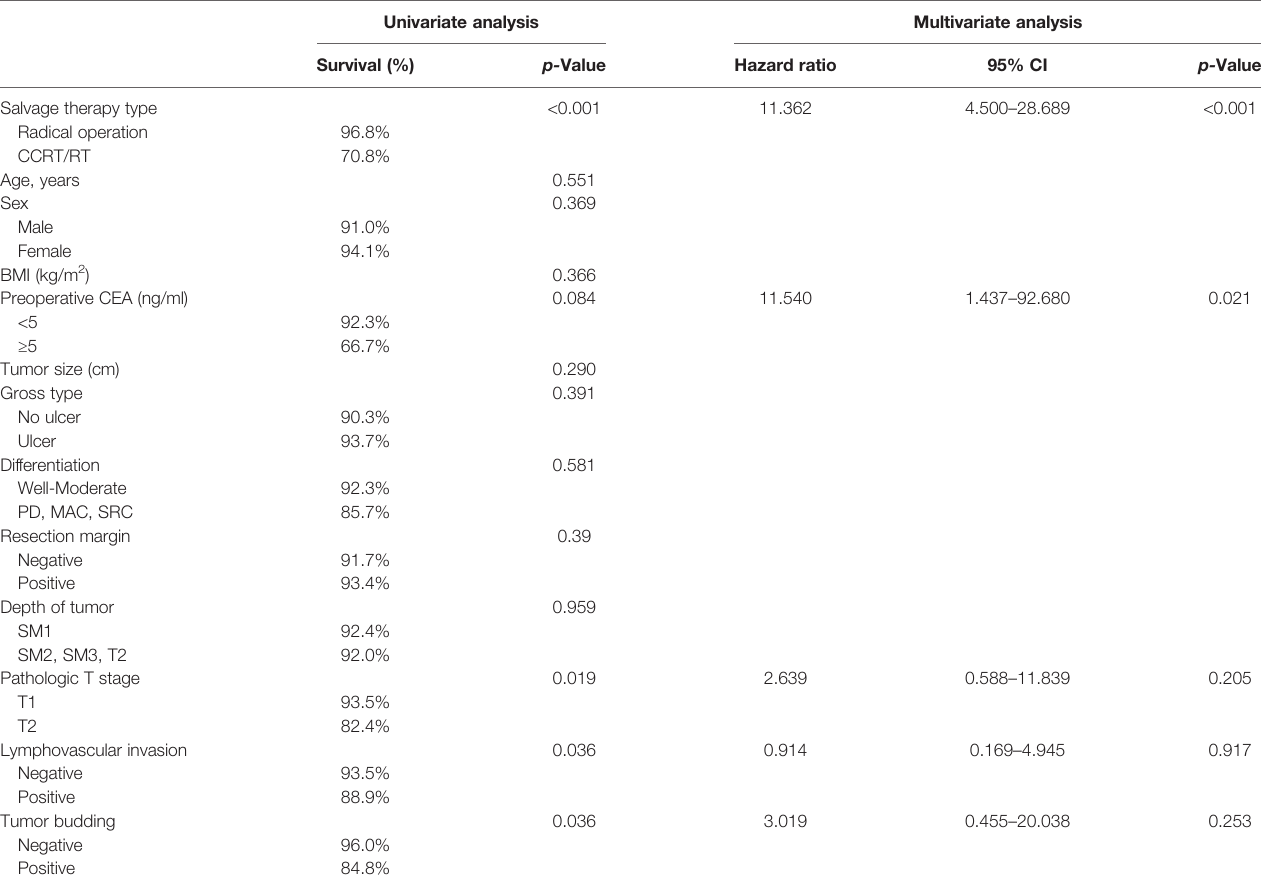
TABLE 3 | Univariate and multivariate analyses of prognostic factors for 5-year disease-free